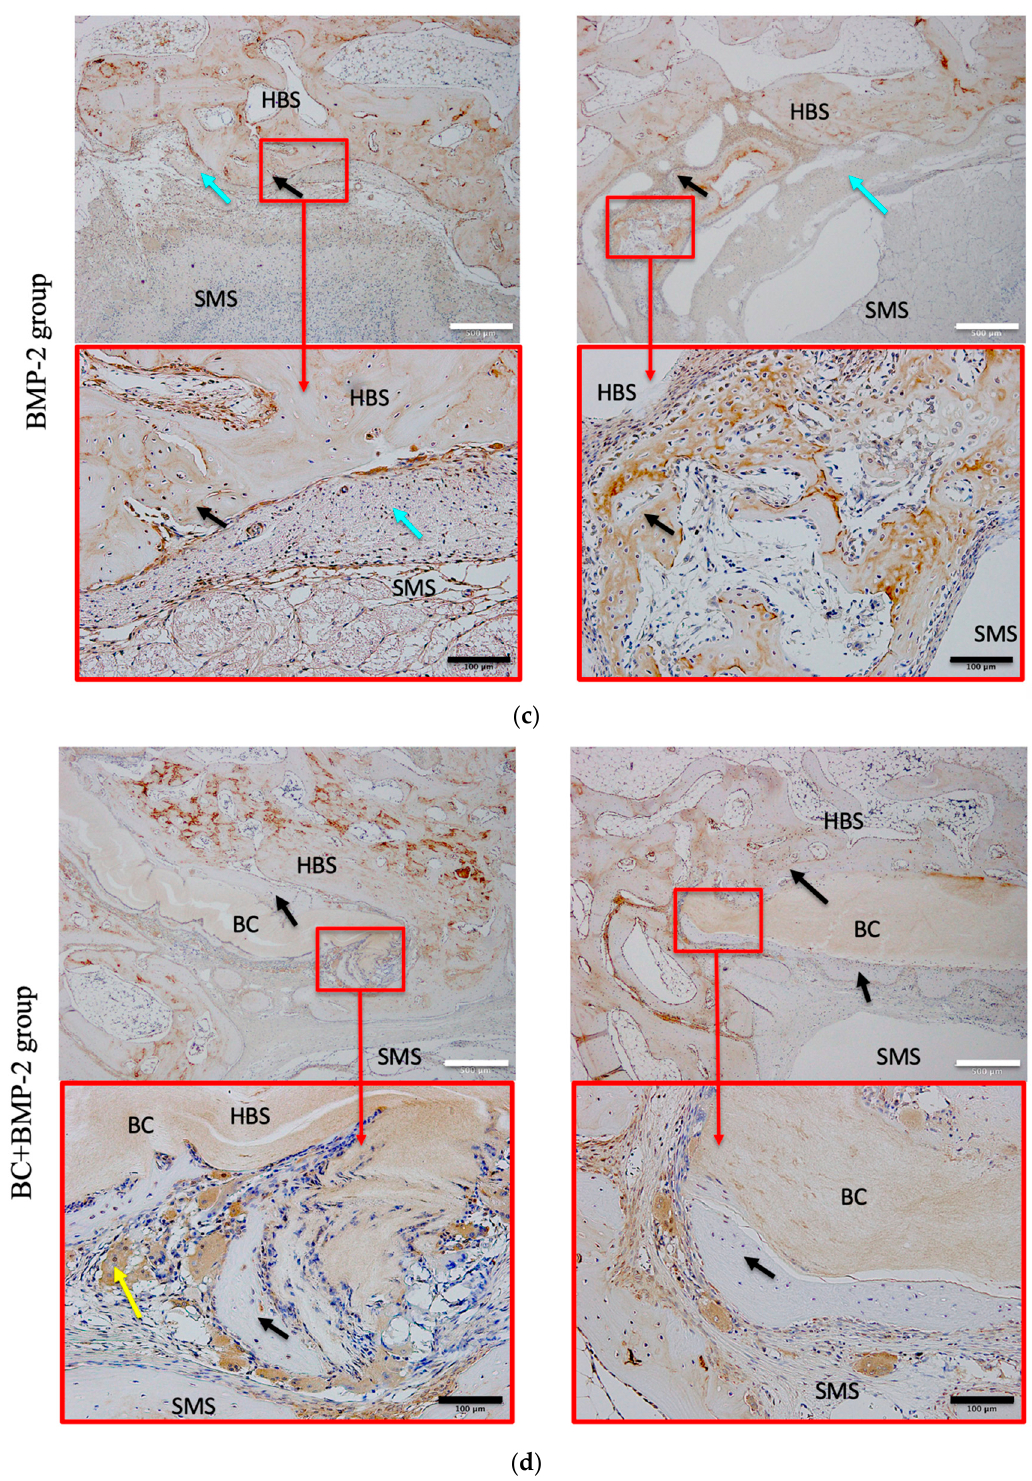
Figure 7. Immunohistochemical staining of OC expression in the ( a ): sham (n = 3), ( b ): BC (n = 3), ( c ): BMP-2 (n = 3), and ( d ): BC + BMP-2 (n = 3) groups at four and eight weeks. Blue arrows indicate connective tissue, black arrows indicate newly formed bone, and yellow arrows indicate cartilage tissue. HBS, host bone side; SMS, sinus membrane side; BC, bacterial cellulose. White scale bars (500 µ m) indicate slices at 4 × magnification; black scale bars (100 µ m) indicate slices at 20 × magnification.